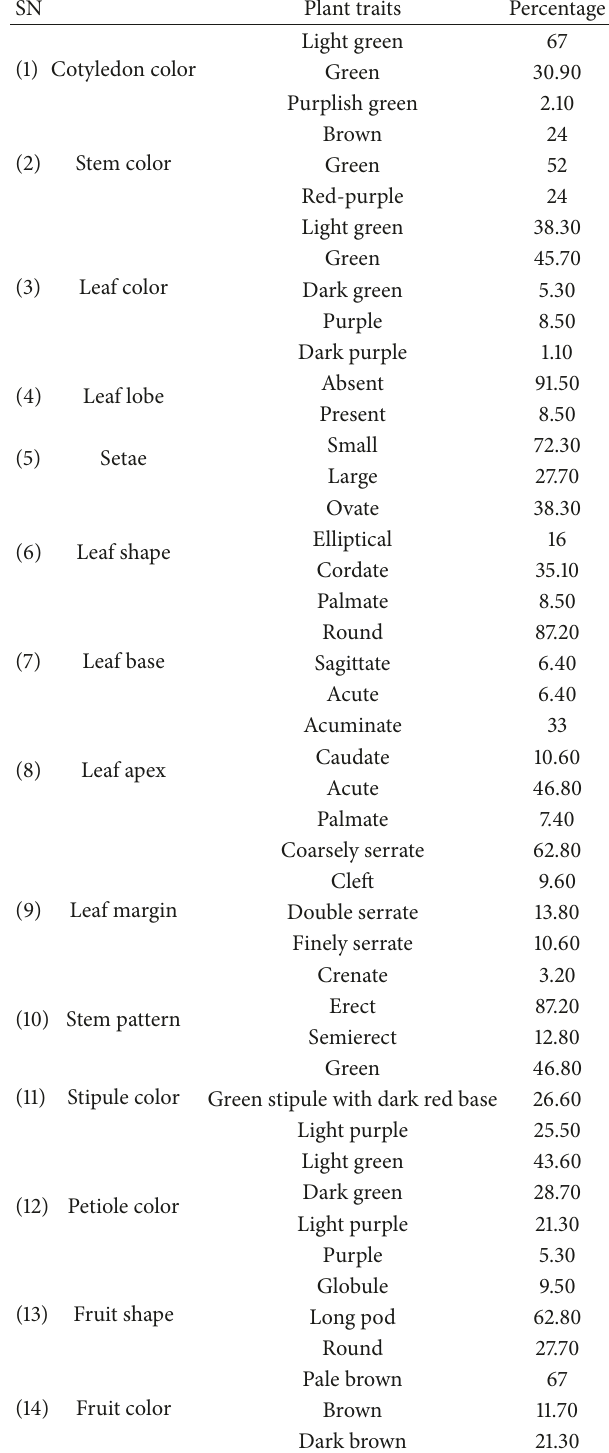
Table 3: Frequency distribution table of qualitative morphological